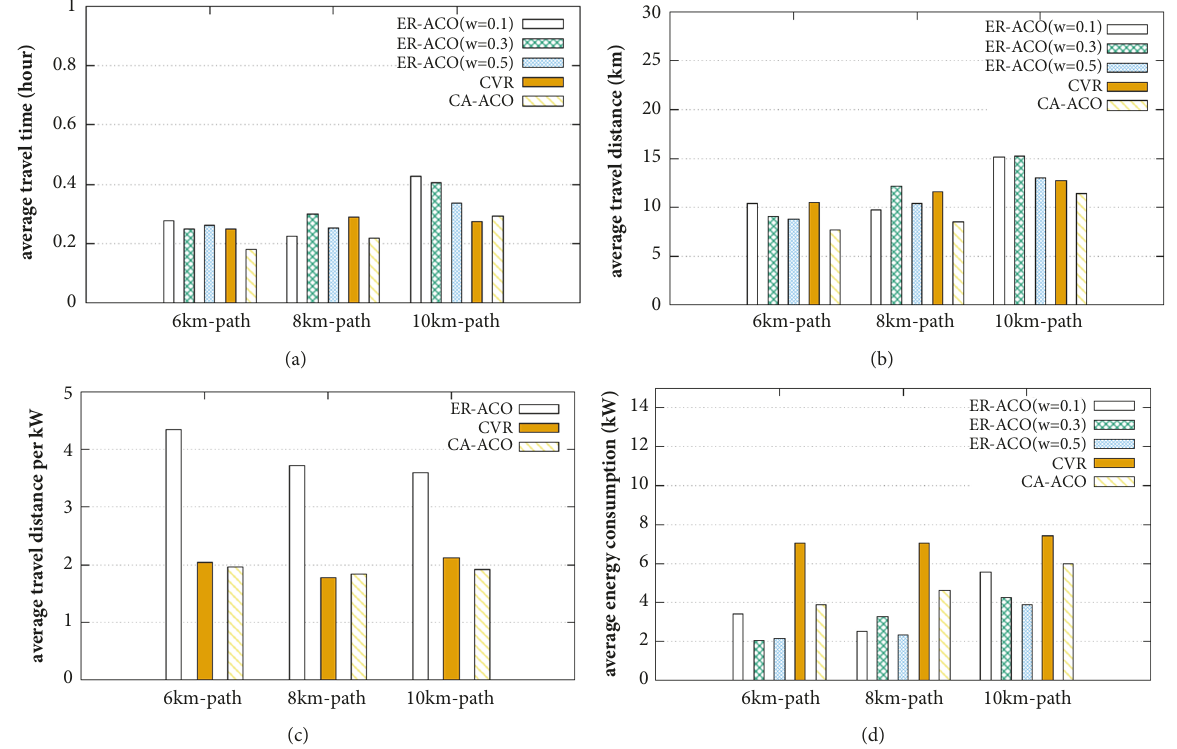
Figure 6: Performance comparison with a varying distance between the source and destination in a Gaussian distribution: (a) travel time, (b) travel distance, (c) travel distance per energy consumption, and (d) energy consumption.